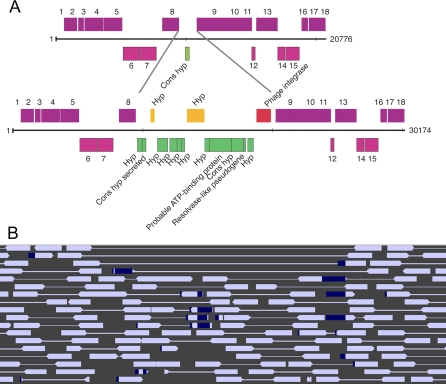
Diagram Showing Gene Content Variation Due to Integrase Insertion in a Region of Contig 11277(A) The gene content of the variant regions are shown. One of these contains an insertion of an integrase (red) and associated genes, mostly hypotheticals or conserved hypotheticals (orange on the top strand, green on the bottom strand). Genes on opposite strands are shown in dark purple (top) or light purple (bottom). Gene annotations are given in text, or by numbers, as follows: (1) putative GTP binding protein; (2) hypothetical protein; (3) protein of unknown function; (4–5) putative peptidase M16; (6) hypothetical protein; (7) putative Na+/H+ antiporters; (8) putative metabolite transport protein; (9) leucyl-tRNA (Cons hyp); (10) protein of unknown function; (11) probable polymerase III; delta subunit; (12) ribosomal protein S20; (13) putative virulence factor, MVIN-like; (14) probable HNH endonuclease; (15) protein of unknown function; (16) hypothetical protein; (17) hypothetical protein; and (18) probable ATPase, PP-loop superfamily.(B) The associated reads are shown. Dark blue regions show inserted sequence divergent from the composite.